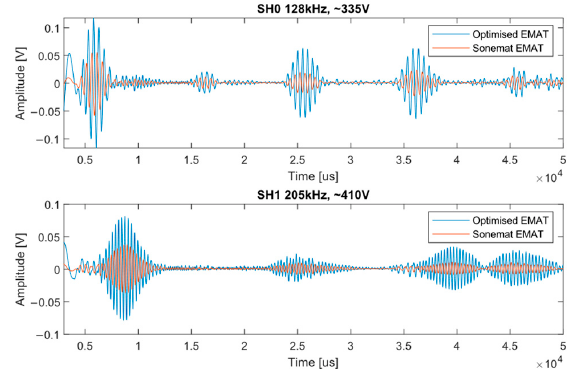
Figure 6. The top graph shows the A ‐ Scans of each transmitter when generating SH0 and the bottom graph shows the A ‐ Scans for SH1. It can be seen clearly the increase in signal amplitude when using the optimised transmitter.